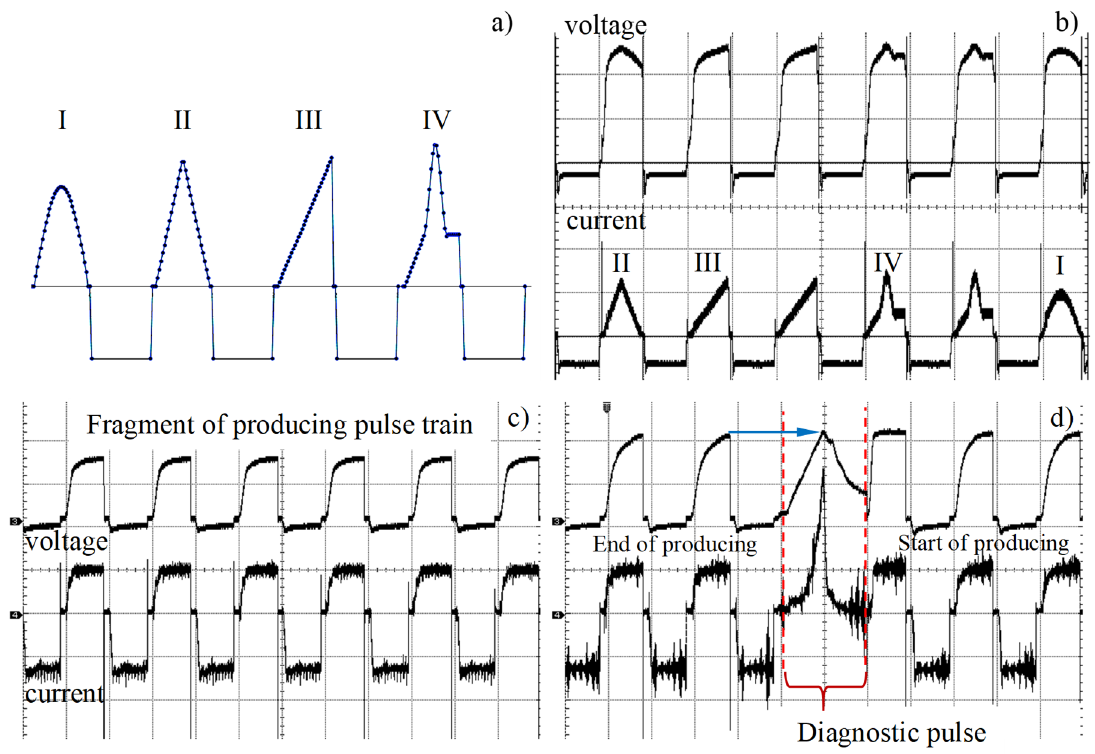
Figure 11. Scheme of tabulated set points for different functions of current ( a ): I—sinusoidal half wave, II—triangle, III—saw tooth, IV—function sequentially composed of linear sweep, part of the sinusoidal, and a constant value; ( b ) corresponding voltage and current output waveforms, as well as output signal waveform within ( c ) the producing pulse train, and ( d ) the triangle diagnostic pulse. PEO process on A2024 Al alloy in a silicate–alkaline electrolyte; 250 V/div, 500 mA/div, 10